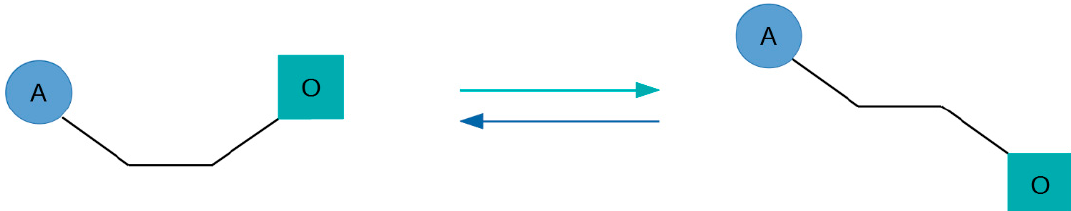
Figure 7. Scheme of isomerization of photo-switchable ligand, consisting of the orthosteric (O) and allosteric (A) moiety connected by the linker.